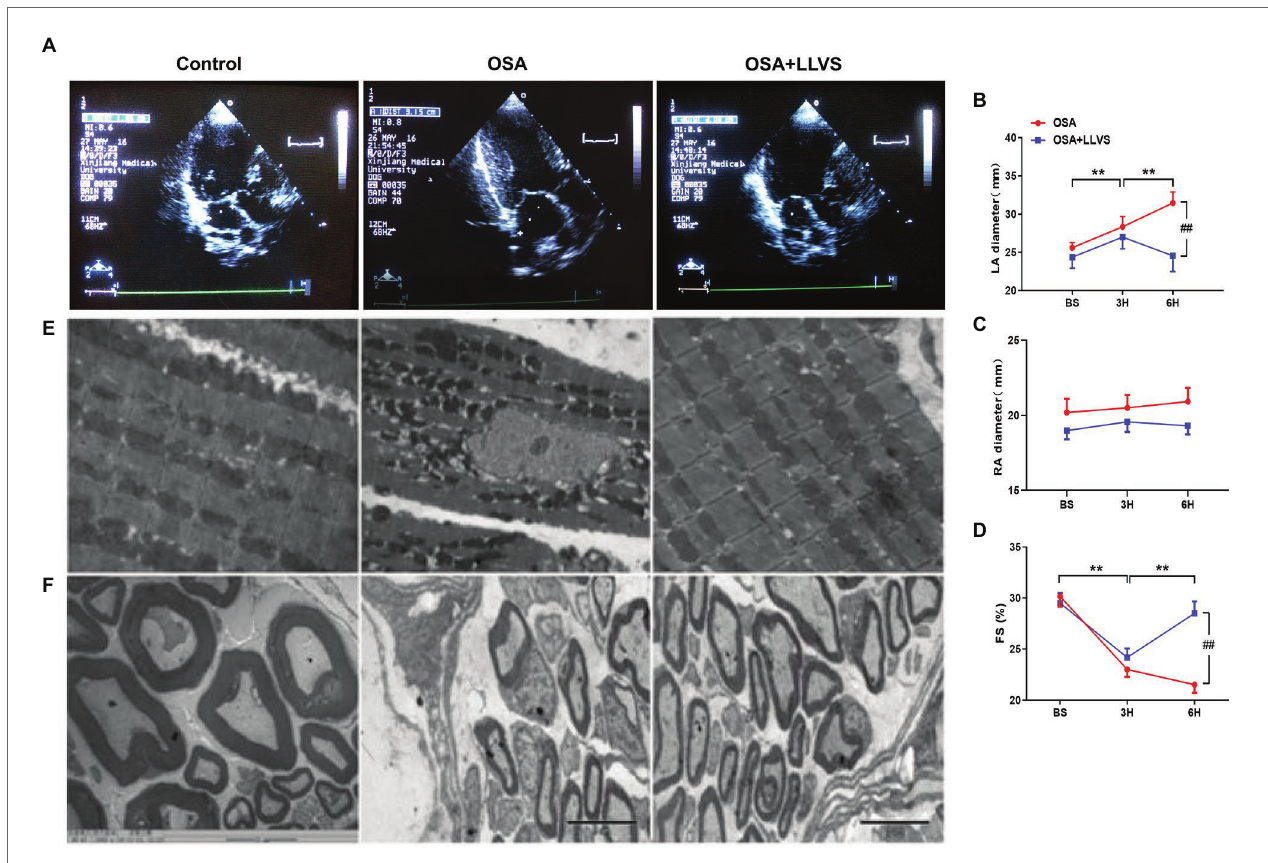
FIGURE 6 | (A) Echocardiography shows images of the LA among the three groups. (B) The LA gradually and significantly increased after OSA, and the LA decreased through LLVS treatment. (C) There was no statistically significant difference in RA among the three groups. (D) OSA-induced FS gradually shorten in the OSA group, and LLVS treatment significantly increased FS. (E) Changes in the mitochondrial and stellate ganglion (F) by transmission electron microscopy among the three groups. ** p < 0.05 vs. the control group; # p < 0.05 vs. the OSA+LLVS group; LA, left atrium; RA, right atrium; FS, fractional shortening; BS, baseline; H,